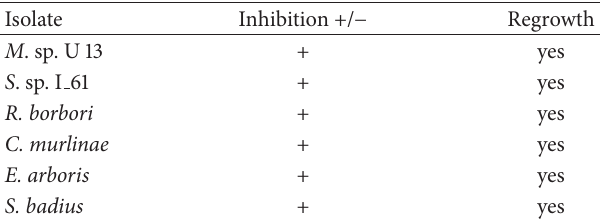
Table 1: Disk diffusion assay data; zones of inhibition are indicated. Regrowth from inhibited zones was tested (𝑛 = 9) ; regrowth indicated a bacteriostatic inhibition not